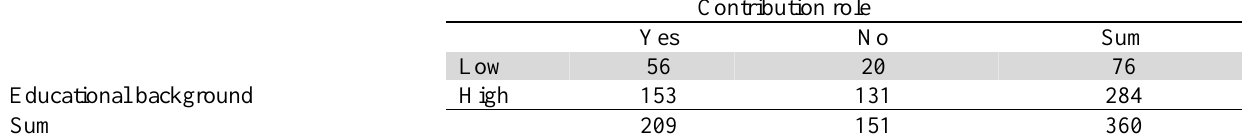
Contribution role